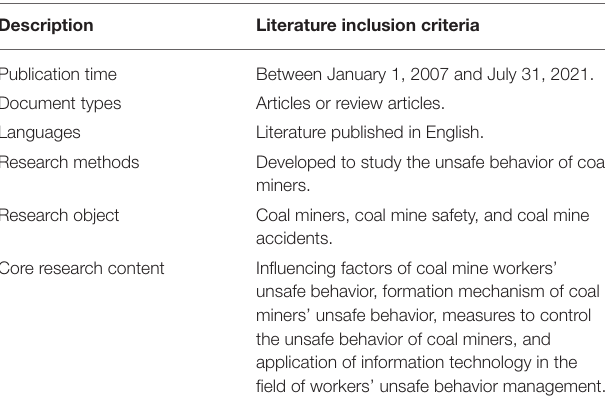
TABLE 1 | Literature inclusion and exclusion